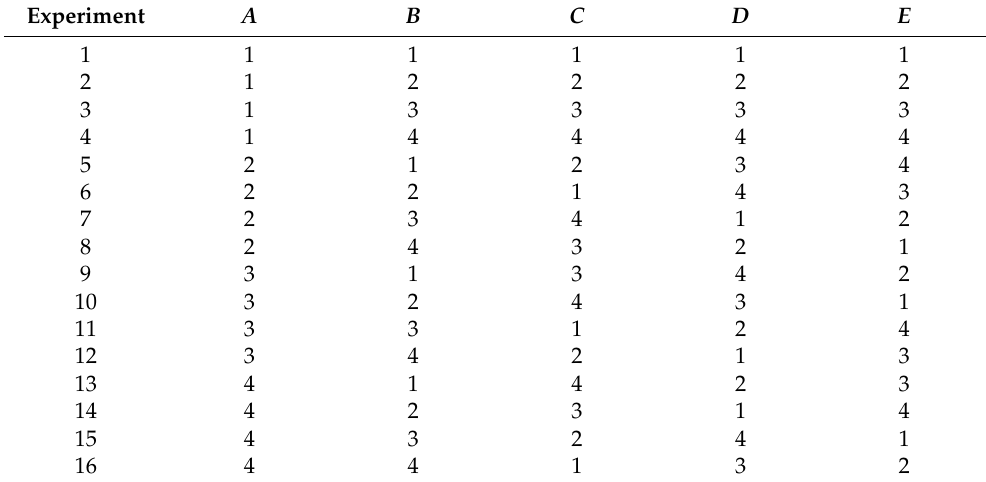
Table 6. L 16 (4 5 ) Orthogonal